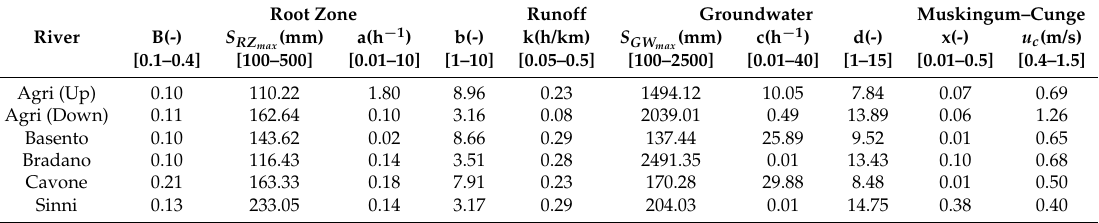
Table 8. Final calibrated parameter sets: for the Agri basin, it was possible to perform multi-site calibration up-dam (Up) and down-dam (Down). Ofanto, Lao, Noce, and Sele are missing since calibration was not carried out.